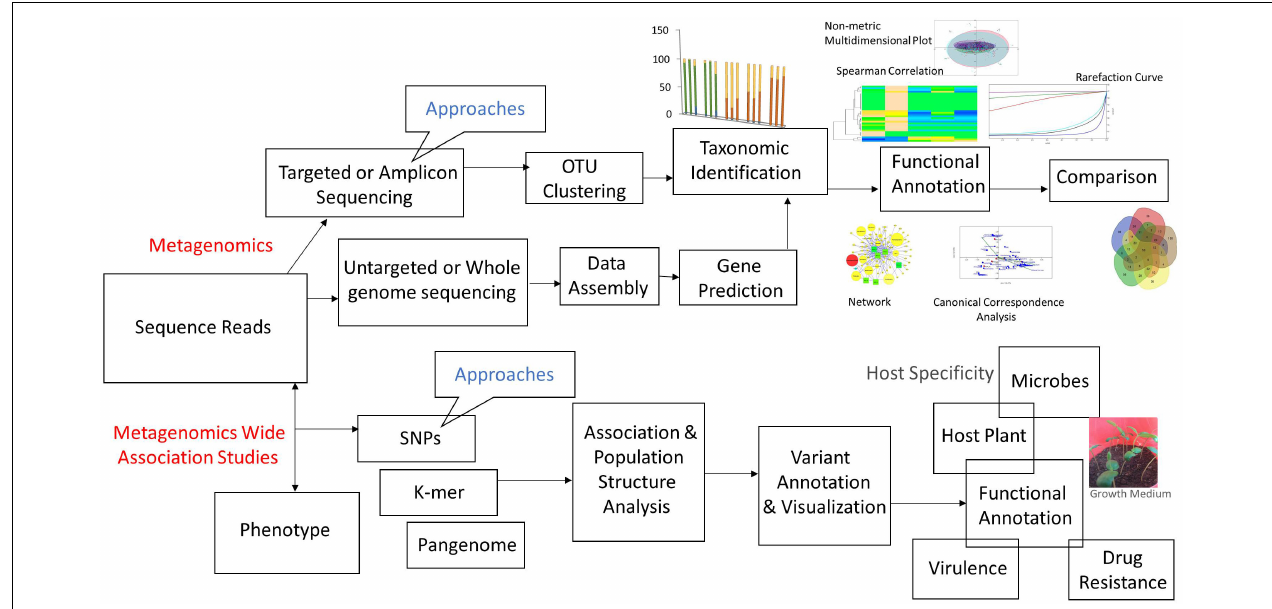
FIGURE 3 | Flow-chart of metagenomics approaches and their association